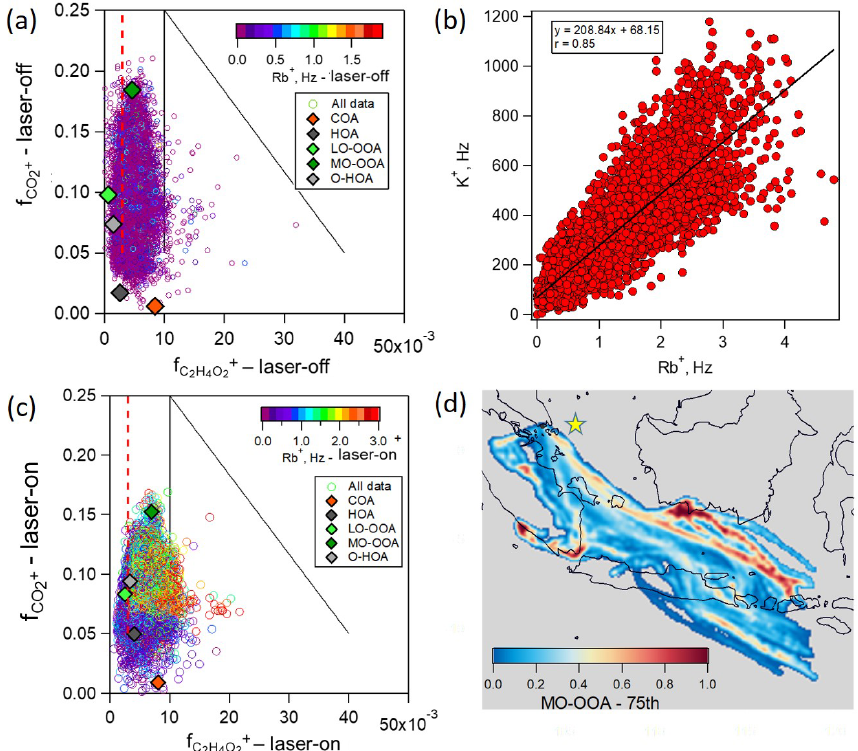
Figure 6. Scatter plots of f vs. f with the symbol color scaled by the rubidium (Rb + ) ion signals based on (a) laser-off and CO + 2 C 2 H 4 O + 2 (c) laser-on measurements: the dash red line shows the 0.3% background value, and plain black lines define the space with and without BB influence (inside and outside the triangular region, respectively, i.e., the black solid lines in panels a and c based on Cubison et al., 2011). (b) Scatter plot of potassium ion (K + ) vs. rubidium (Rb + ) signals from the laser-on measurements. (d) PSCF graph of MO-OOA considering only pollutant concentrations above their respective 75th percentile (Fig. S15 shows the PSCF graphs of K + , Rb + , and C 2 H 4 O +